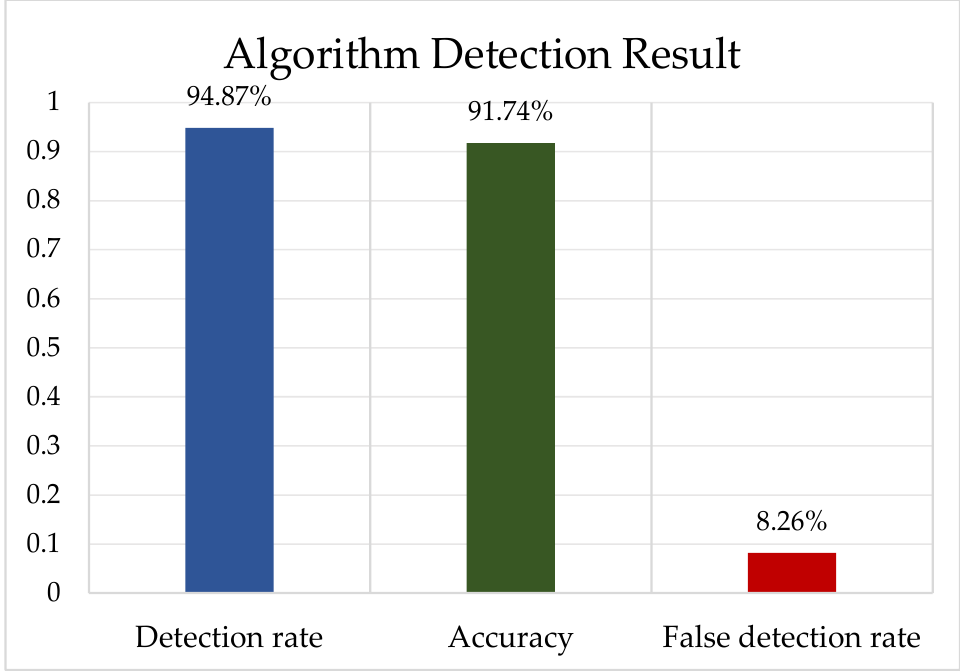
Figure 12. Algorithm detection result.